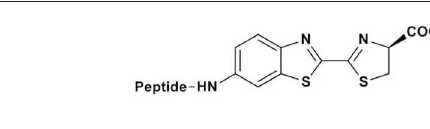
FIGURE 1 | The operation of the bioluminescent system.